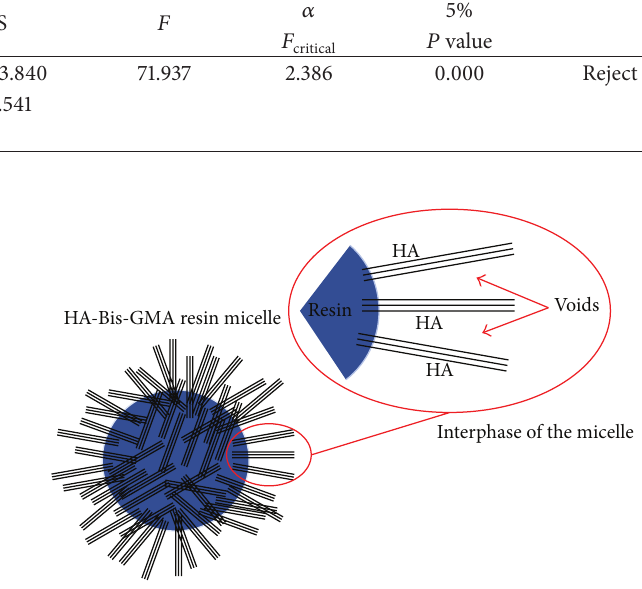
Figure 6: Schematization of hydroxyapatite whiskers/matrix inter- action. Three fundamental components can be highlighted in the composite: the resin which consists predominantly of Bis-GMA which is shown in blue, the filler of hydroxyapatite (HA) with needle-like morphology (whiskers) and micrometric size, and the voids in